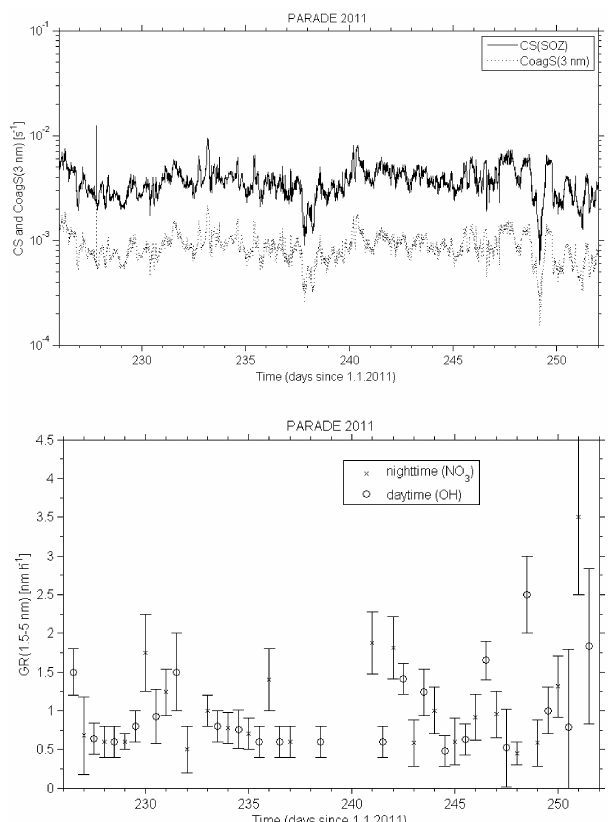
Figure 12. Top: calculated condensation (CS) and coagulation sinks (CoagS ( 3nm ) ) Bottom: mean growth rates (GR) of clusters or par- ticles between 1.5 and 5nm in